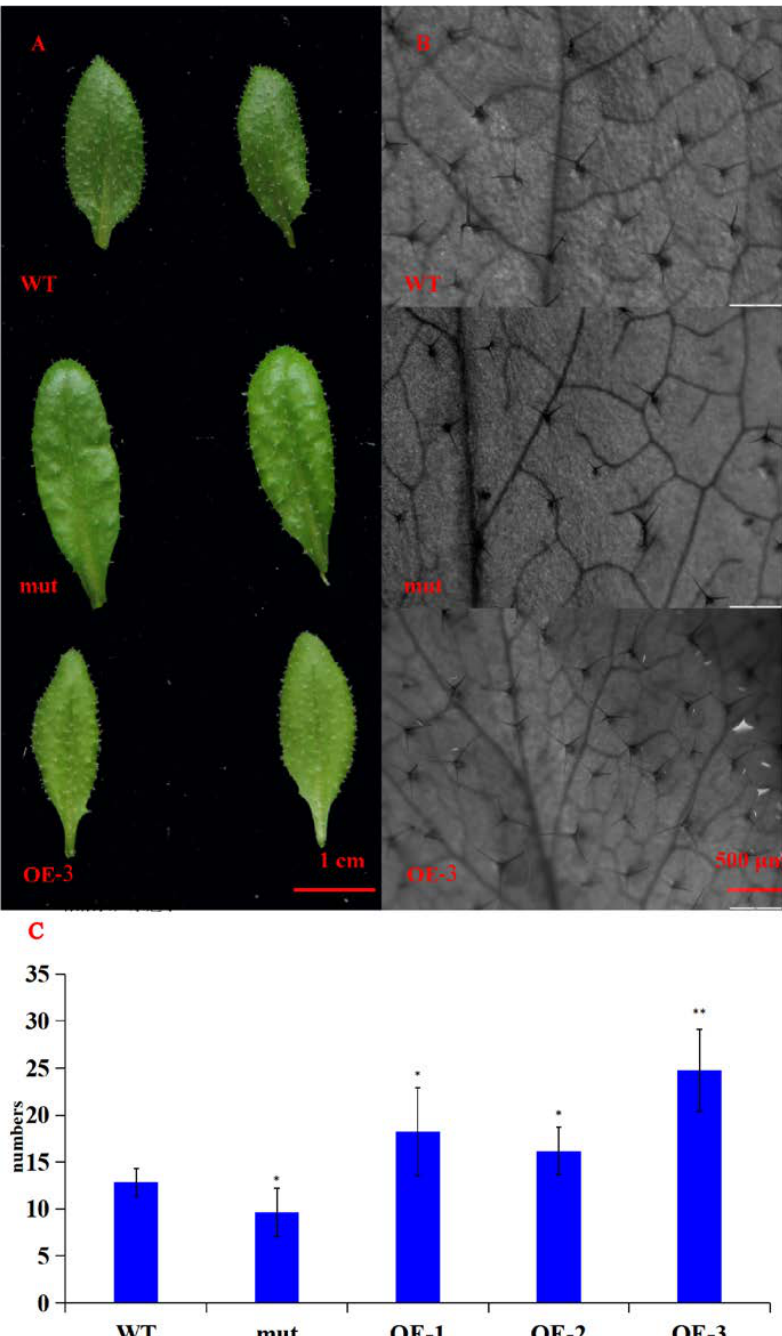
Figure 10. Phenotypic identification of transgenic A. thaliana . ( A ) The rosette leaves of wild type A. thaliana (WT), mutant A. thaliana (mut), and transgenic T5 generation A. thaliana line 3 (OE-3) under camera (bar, 1 cm); ( B ) The pictures of transgenic T5 A. OE-3 (OE), wild type A. thaliana (WT) and mutant A. thaliana (mut) leaves under the stereomicroscope (bar, 500 μm, and area, 38 mm 2 ); ( C ) The statistical data of the number of trichomes of transgenic T5 A. thaliana (OE-1, OE-2, OE-3), wild type A. thaliana (WT) and mutant A. thaliana (mut). The results showed that the number of trichomes of GhWRKY53 transgenic lines was significantly more than that of the wild type and the mutant in A. thaliana . The significance of difference was analyzed with two tailed t test (* 0.01< p <0.05,** p <0.01). Data are represented as average values with SD.